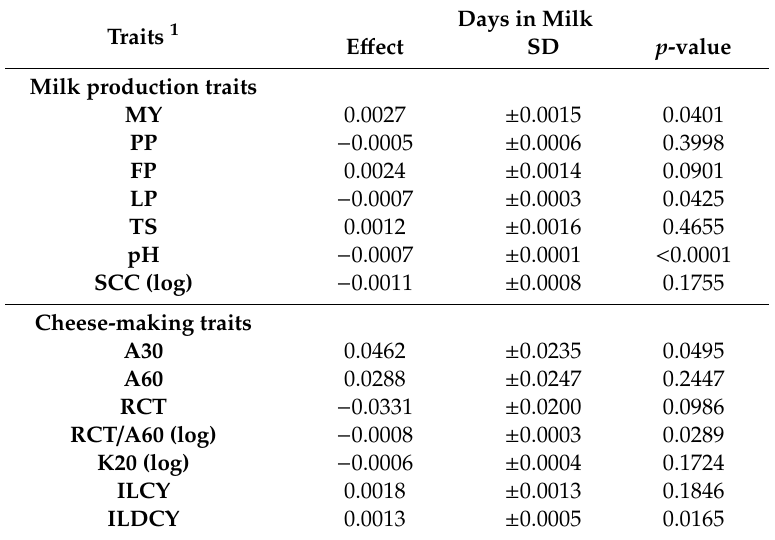
Table 2. E ff ect of the DIM covariable on the milk and cheese-making traits under investigation. Traits